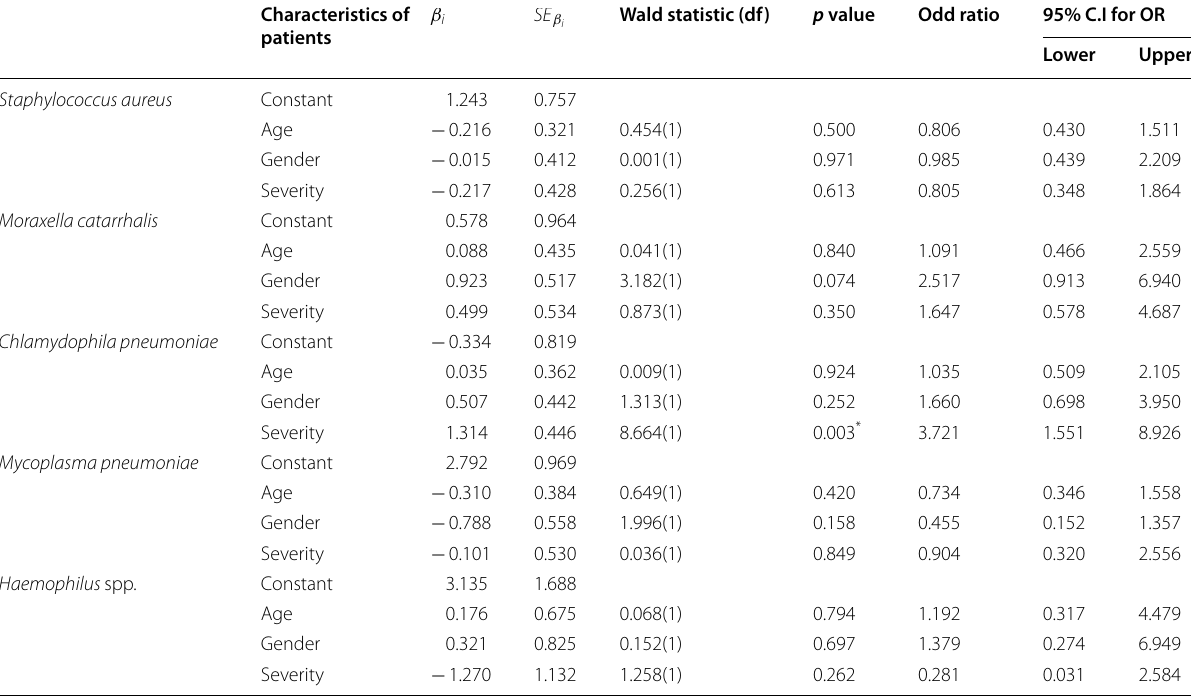
β i : estimated coefficients, SE β i : standard error of the estimated coefficients *Significant at 5%